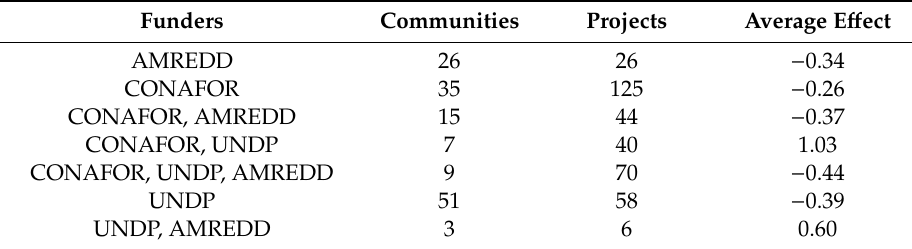
Figure 8. Proportions of REDD + -intervened communities reducing deforestation rates (e ff ective) or maintainingorincreasingdeforestationrates(ineffective)inCampeche,QuintanaRoo,andYucatanstates. Table 5. Average REDD + e ff ect on community (ejido) deforestation rate as per intervening funders and number of associated projects (CONAFOR = National Forestry Commission, UNDP = United Nations Development Program, AMREDD = Mexico REDD +